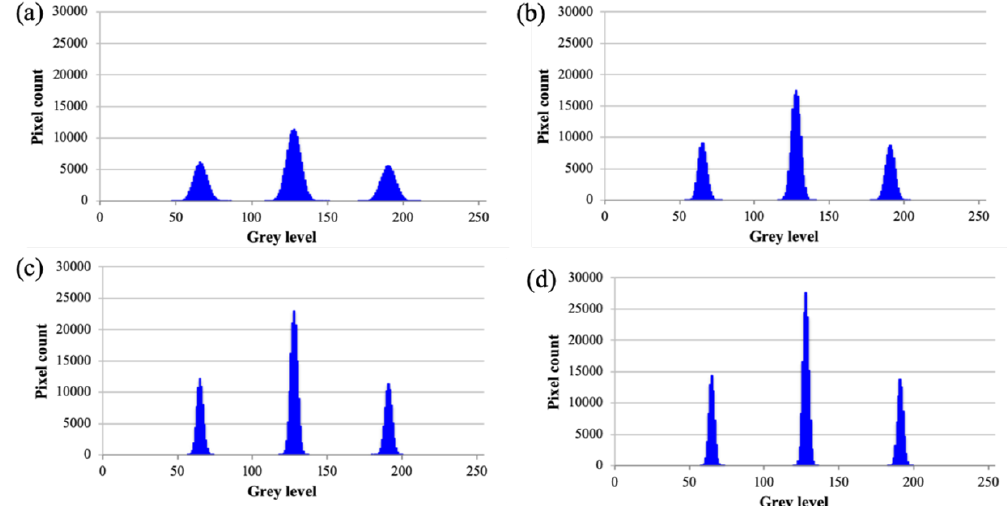
Figure 3. The distributions of grey values in the reconstructed images after ( a ) 50; ( b ) 100; ( c ) 150; and ( d ) 200 GS iterations.